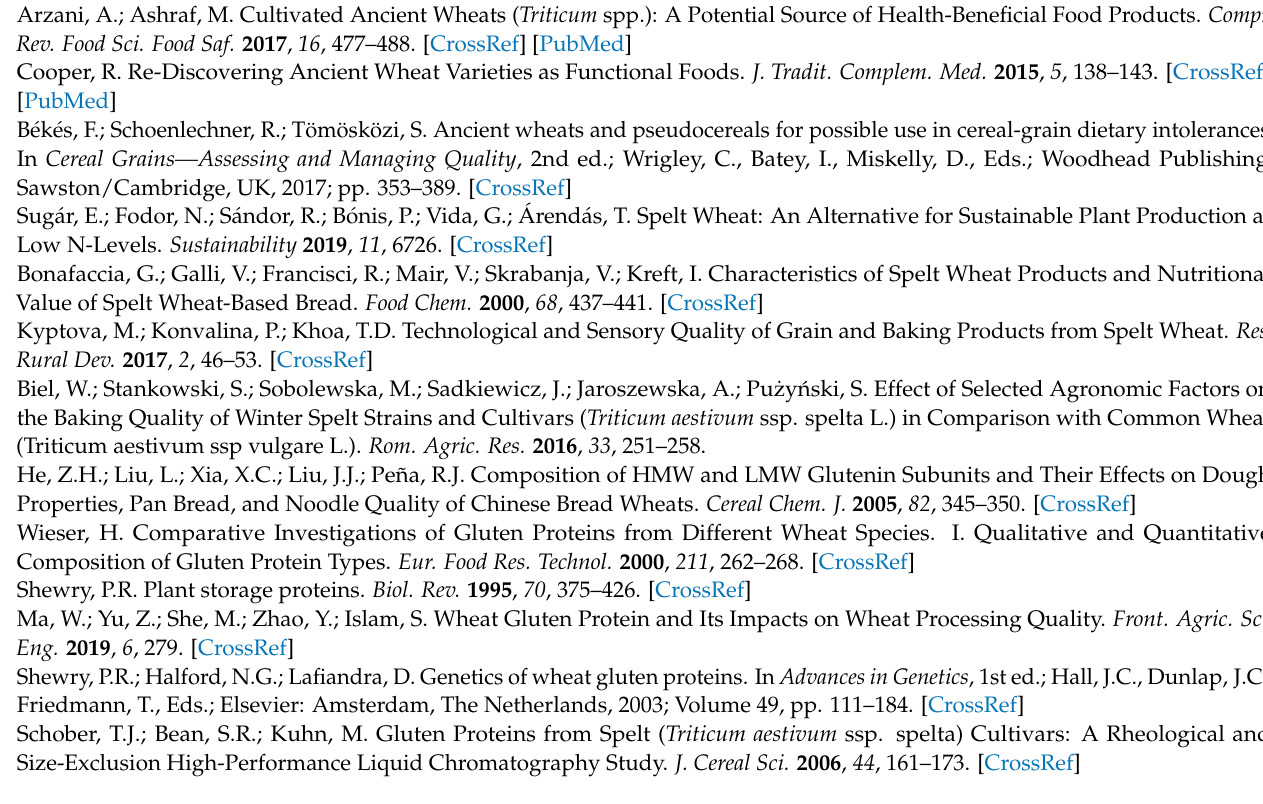
Figure S3: The chromatogram for RP-HPLC analysis representing the individual peaks for ω , α + β and γ